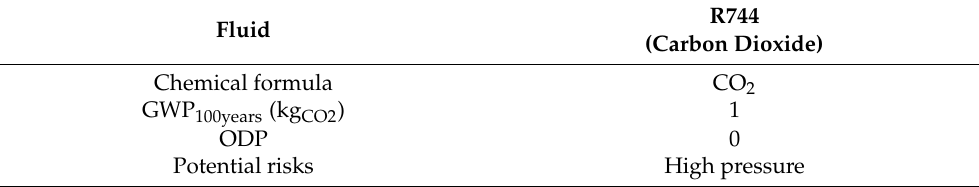
Table 7. Characteristics of carbon